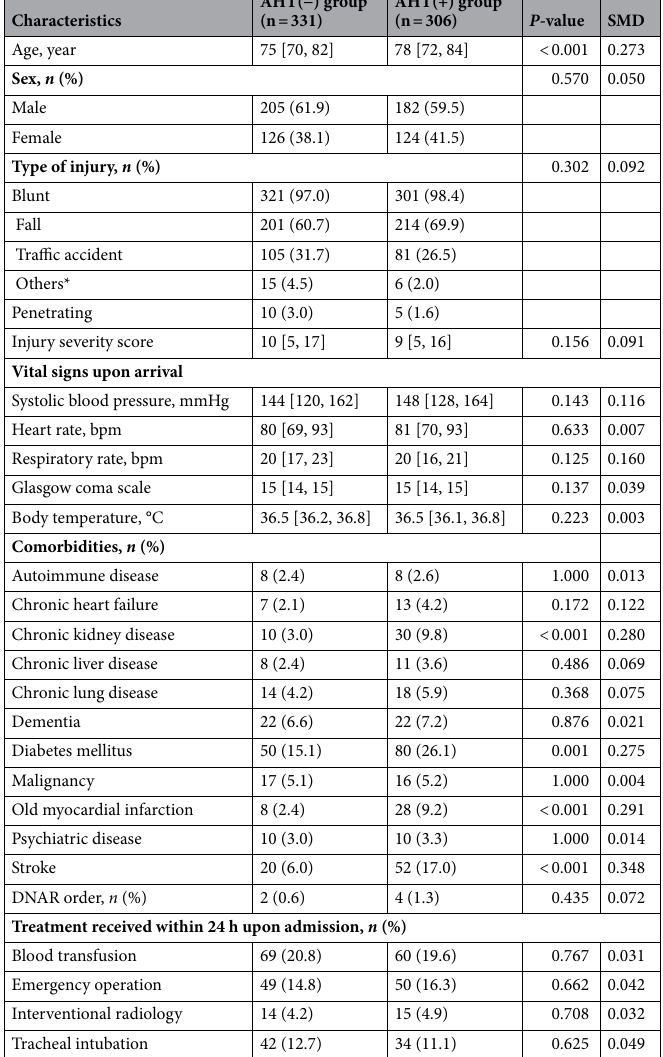
Table 1. Baseline characteristics of older trauma patients with or without antihypertensive drugs. Categorical variables are presented as counts and percentages (%), whereas numerical variables are presented as median and interquartile ranges. The balance between the two groups was evaluated using the SMD; an SMD > 0.1 was considered significant. *Others included crush, sports, animal-related, and abuse. AHT Antihypertensive drug, DNAR Do not attempt resuscitation, SMD Standardised mean